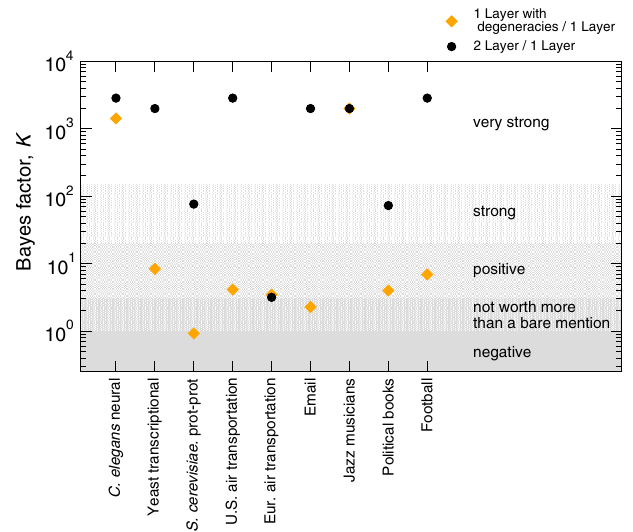
FIG. 6. Model comparison using Bayes factors. We show the Bayes factor K [Eq. (7)] for all the real-world network examples we analyze (see text). Black dots show results for the Bayes factor considering the two-layer AND SBM and the single-layer SBM. Orange diamonds show the Bayes factor considering the single- layer SBM with a degeneracy factor and the single-layer SBM. The regions in different shades of gray indicate the qualitative scale introduced by Kass and Raftery to map K values to human perceptions of strength of evidence [60] ( “ negative, ” K < 1 ; “ not worth more than a bare mention, ” 1 < K < 3 ; “ positive, ” 3 < K < 20 ; “ strong, ” 20 < K < 150 ; “ very strong, ” K > 150